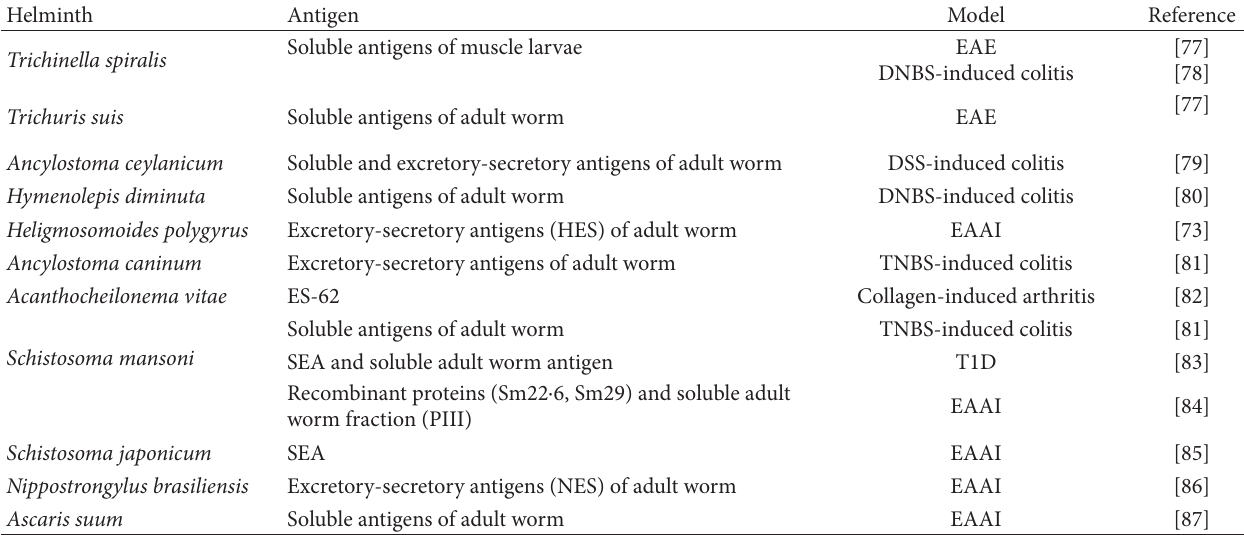
EAE: experimental autoimmune encephalomyelitis; DNBS: dinitrobenzene sulfonic acid; TNBS: trinitrobenzene sulfonic acid; DSS: dextran sodium sulfate; T1D: type 1 diabetes; EAAI: experimental allergic airway